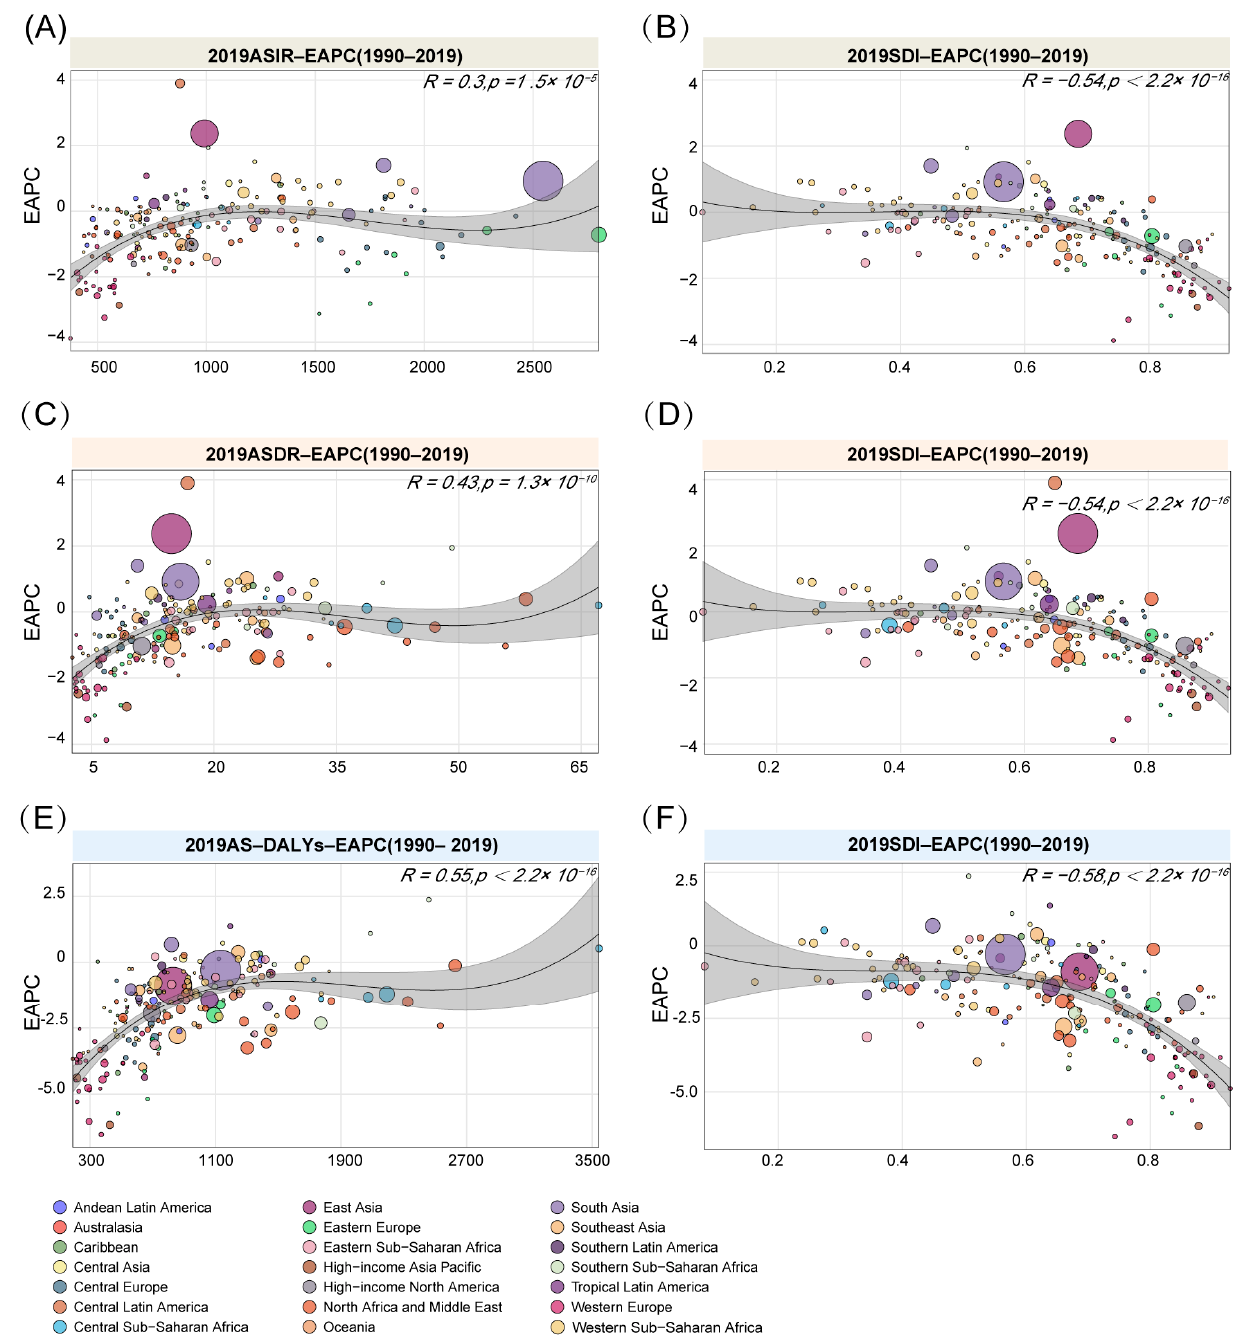
Figure 3. The relation between EAPC and ASXR/SDI index. ( A , B ) ASIR-EAPC correlation analysis with ASIR and SDI index; ( C , D ) ASDR-EAPC correlation analysis with ASDR and SDI index; ( E , F ) AS-DALYs-EAPC correlation analysis with AS-DALYs and SDI index.